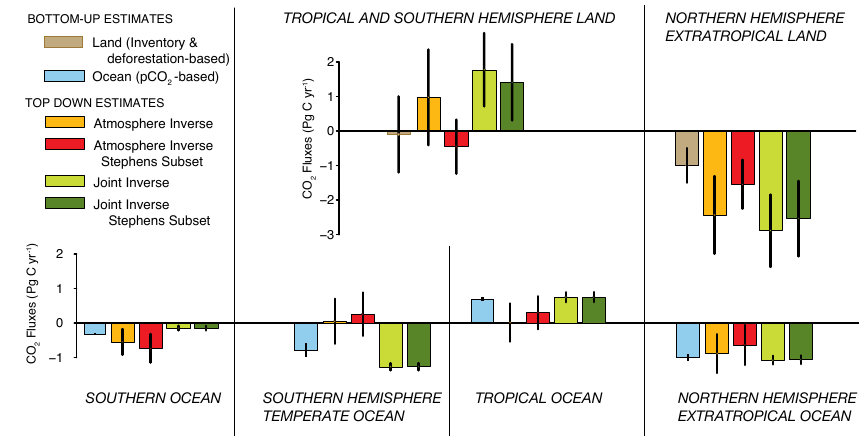
Fig. 4. Regional flux estimates for the land and ocean. The bottom-up land inventory estimates are as described in the text and shown in Fig. 3. The ocean p CO 2 based estimates are from Takahashi et al. (2009), the atmosphere inverse results are from the Transcom-3 study of Gurney et al. (2004), the “Atmosphere Inverse Stephens Subset” is from a new atmospheric inverse calculation we did as part of this study using a subset of three of the Transcom-3 atmospheric transport models that provide a better fit to certain criteria based on observed vertical profiles of CO 2 in the atmosphere (Stephens et al., 2007), the joint inverse is from Jacobson et al. (2007a), and the “Joint Inverse Stephens Subset” is from a new calculation we did using the Stephens subset of Transcom-3 models. Note that the oceanic data constrain the air-sea flux so strongly that the results of ocean-only inverse studies (e.g., Gruber et al., 2009), i.e., those that do not include the atmospheric constraint used in the joint inverse, give virtually the same answer as the joint inverse. The latitude boundaries used to calculate the ocean uptake are 44 ◦ S, 18 ◦ S and 18 ◦